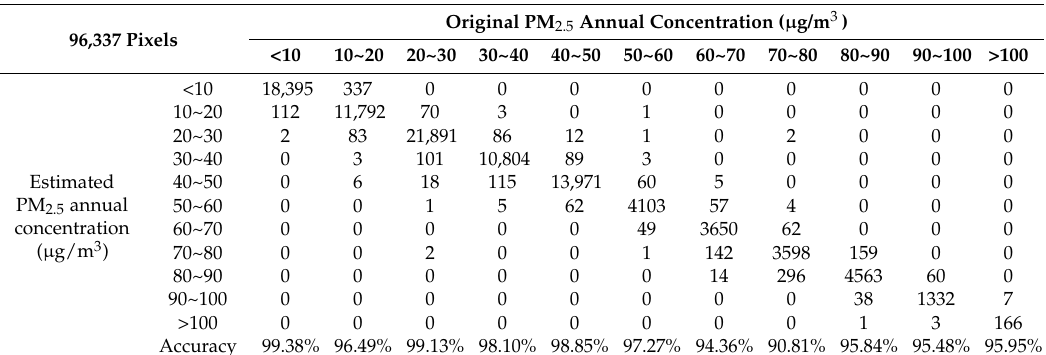
Table 2. The confusion matrix of the original vs. estimated PM 2.5 annual concentrations by the deep CNN model fed by the four influencing factor data: population, GDP, terrain, and